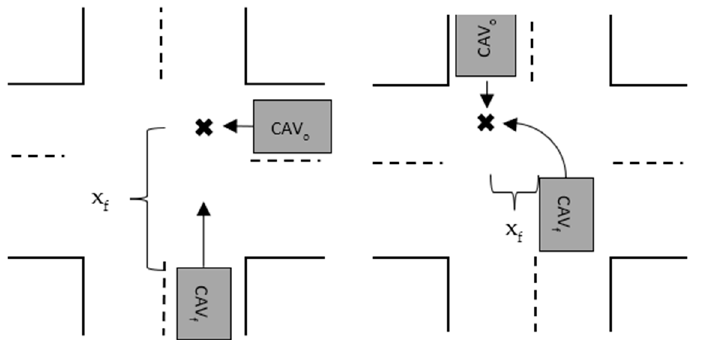
Figure 4. Visualisation of the distance to the collision point (X f ) from the at-fault car’s point of view used in the TTC analysis when the at-fault car was going straight through the intersection ( left figure ) or turning left ( right figure ).